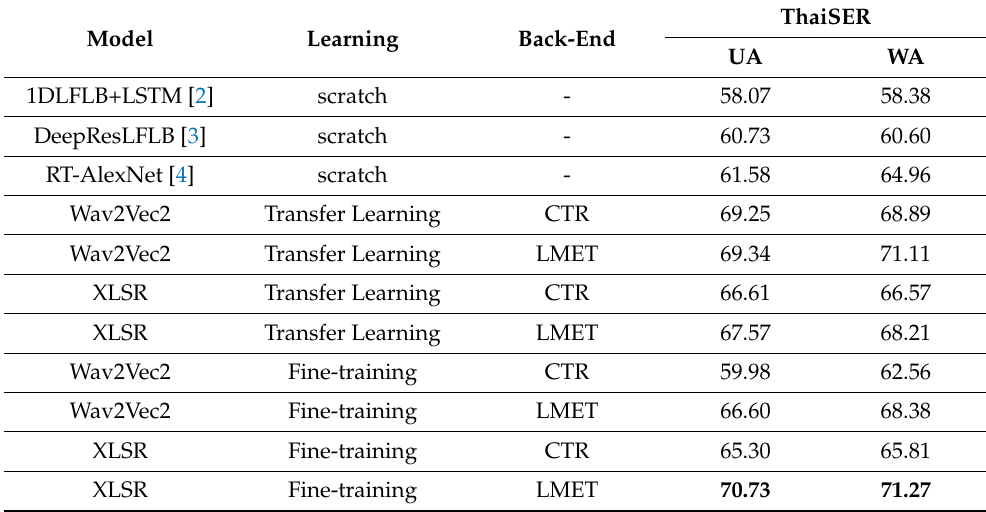
Table 3. Comparison of our proposed framework and baseline average UA and WA metrics on the ThaiSER dataset. The numbers in bold indicate the row with the best performance.